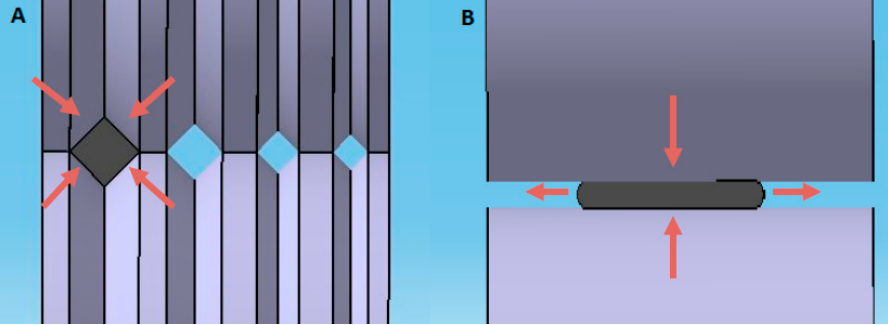
Figure 1. Grooved cold rolling ( A ) versus conventional rolling ( B ), the red arrows correspond to the in plane displacement direction induced by the process. Table 1. Different grooved cold rolling deformation level produced for microhardness and tensile test, grayed background correspond to samples used for electron back scattered diffraction (EBSD) analyses. e i